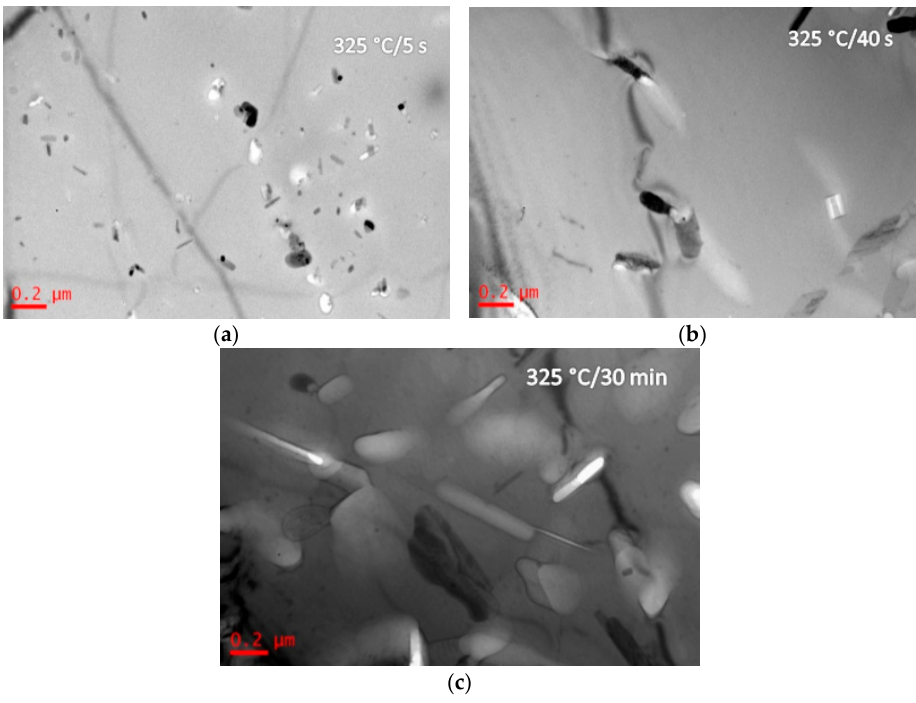
Figure 4. BF images of the studied alloy having been isothermal heat treated at 325 °C for different durations. The IHT durations are: ( a ) 5 s; ( b ) 40 s; and, ( c ) 30 min.